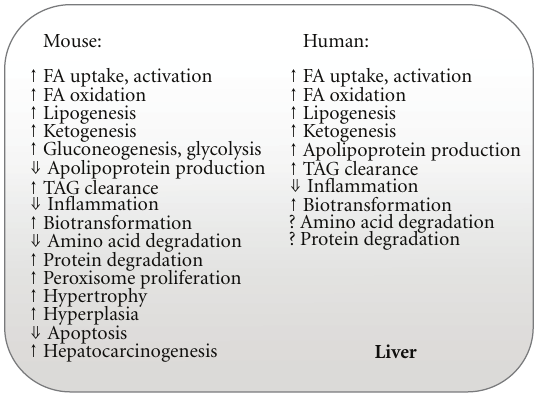
Figure 1: Examples of the multiple metabolic e ff ects of PPAR α acti- vation in mouse or human liver. FA, fatty acid; TAG,